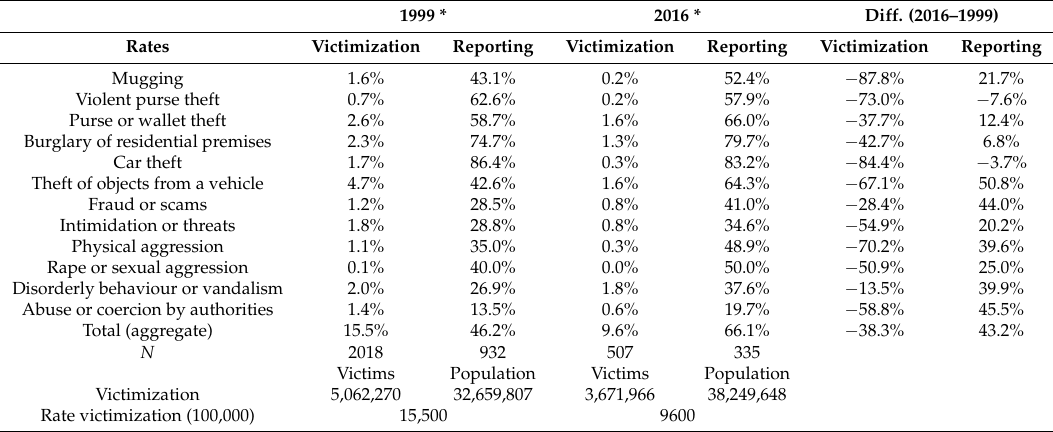
Table 2. Comparison of the victimization and reporting rates by type of crime derived from the 1999 and 2016 surveys for